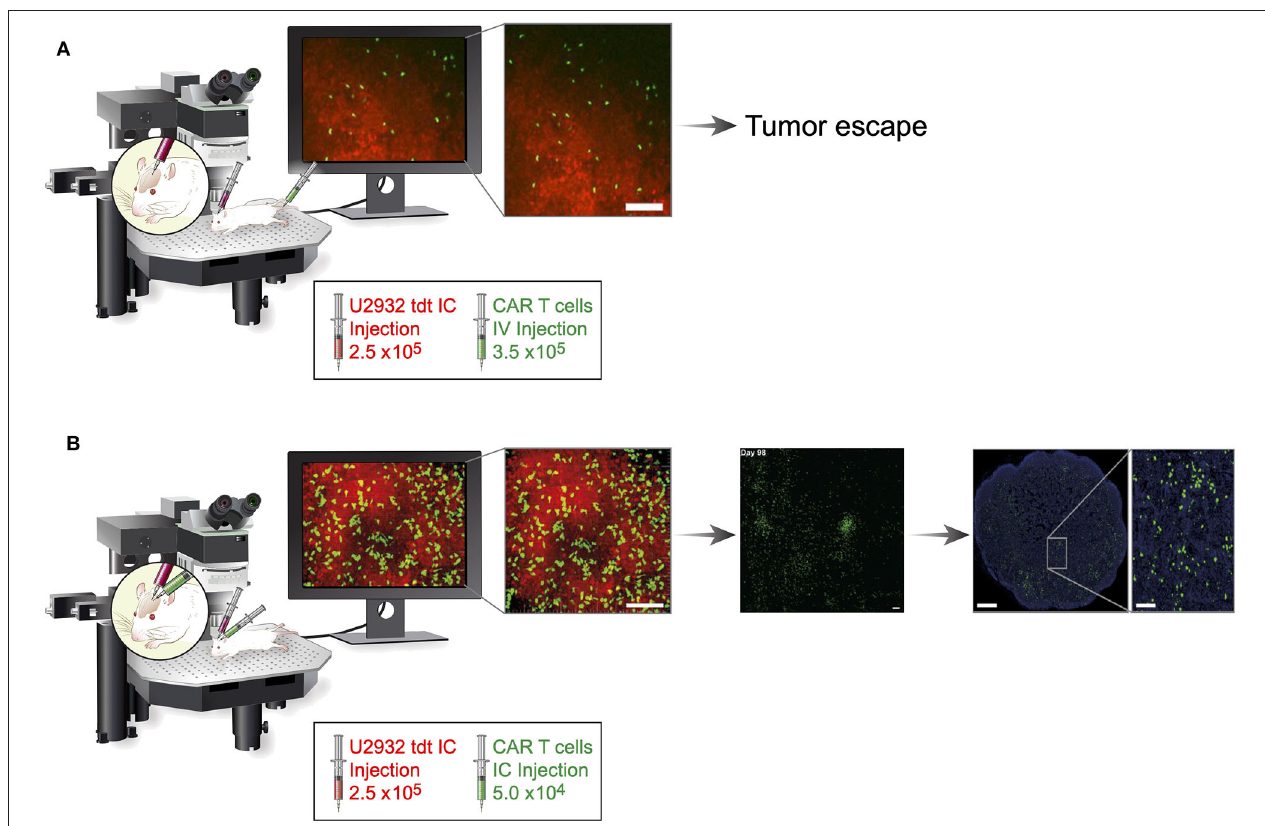
FIGURE 1 | Schematic comparison of systemic and regionally delivered h19m28z CAR T cells in a PCNSL mouse model. Fourteen days after establishment of the cranial window, 2.5 × 10 6 U2932 tdt (red) cells were injected (diluted from 1 µ L of PBS to 2 µ L of PBS) orthotopically in homozygous male NMRI Foxn1 nu / nu mice. Fourteen days after implementation of tumor cells, h19m28z CAR T cells (green) were administered either intravenously by injecting 3.5 × 10 5 cells (diluted from 100 µ L of PBS to 200 µ L of PBS) or intracerebrally by injecting 5 × 10 4 cells (diluted from 1 µ L of PBS to 2 µ L of PBS). (A) Intravenous administration resulted in a low presence (infiltration, accumulation, and depth) of h19m28z CAR T cells, without a sustained effect on tumor cells, in the majority of mice. (B) In contrast, after intracerebral injection, h19m28z CAR T cells were present at higher numbers and higher depth, compared with mock CAR T cells. h19m28z CAR T cells also had low velocity, compared with mock CAR T cells, owing to immune synapse formation and the killing of tumor cells, leading to reduced PCNSL growth and tumor regression. Moreover, compared with the mock CAR T cells, which persisted for < 3 weeks, h19m28z CAR T cells were found to persist for up to 159 days (central panel) and migrated to non-draining lymph nodes (right panel). IC, intracerebral; IV, intravenous. This figure includes cropped figures from the article “Long-term in vivo microscopy of CAR T cell dynamics during eradication of CNS lymphoma in mice” by Mulazzani et al. (4), under Creative Commons CC-BY-NC-ND 4.0. Permission has been provided by authors of the original work to share modified